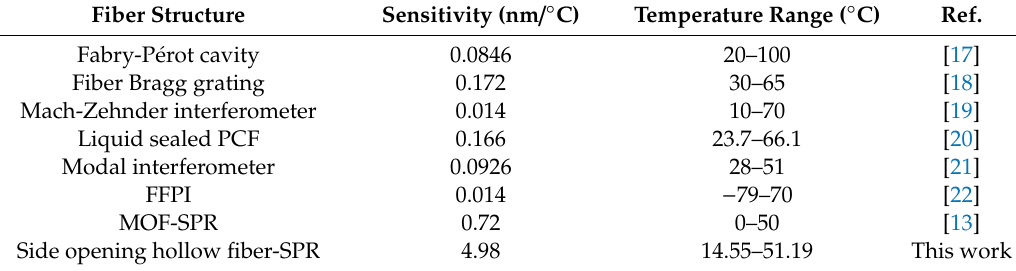
Figure 6. Losses as a function of wavelength for the ( a ) x -polarized and ( b ) y -polarized core modes at n = 1.47, with varying nanowire positions ( θ ). For other fabrication tolerances, the effect of the parameters w = 0.4 Λ , d c = 2.6 Λ and d g = 200 nm on the SPR spectra at n = 1.47 are shown in Figures 7–9. As shown in Figure 7, the position of the resonance peak is less affected by w , indicating that the sensor has good stability in the range of ±10% fabrication tolerance of w . However, as the d c increases in Figure 8, the resonance peak shifts toward the short wavelength direction, which is because the increase in d c causes the Re( n eff ) of the core mode to become larger, as shown in Figure 8a,b, resulting in the intersection of the Re( n eff ) curves of the core mode and the SPP mode, that is, the peak shifts to the short wavelength direction. The increase in d c also reduces the loss of the core mode, which can make the resonance peak width narrower, as seen from Figure 8c,d, and leads to a better resolution. Figure 9 shows the effect of d g on the loss spectra of the proposed sensor, where d g changes in the range of –10% to 10%, and the resonance peak shifts toward the long wavelength direction as d g increases. This is because the increases in d g increases the Re( n eff ) of the SPP mode, as shown in Figure 9a,b, and thus leads to the intersection (the peak) which moves toward the long wavelength, as seen from Figure 9c,d. In general, when the gold nanowire is within ±20° deflection range and the sensor parameters ( w , d c , and d g ) are within ± 10% tolerances, the SPR phenomenon is relatively stable, indicating that the sensor can work normally.